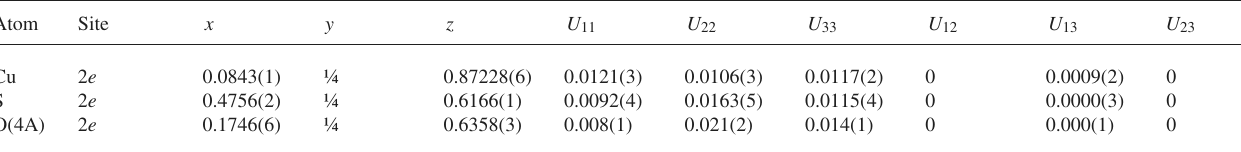
Table 3. Atomic coordinates and displacement parameters (in Å 2 )